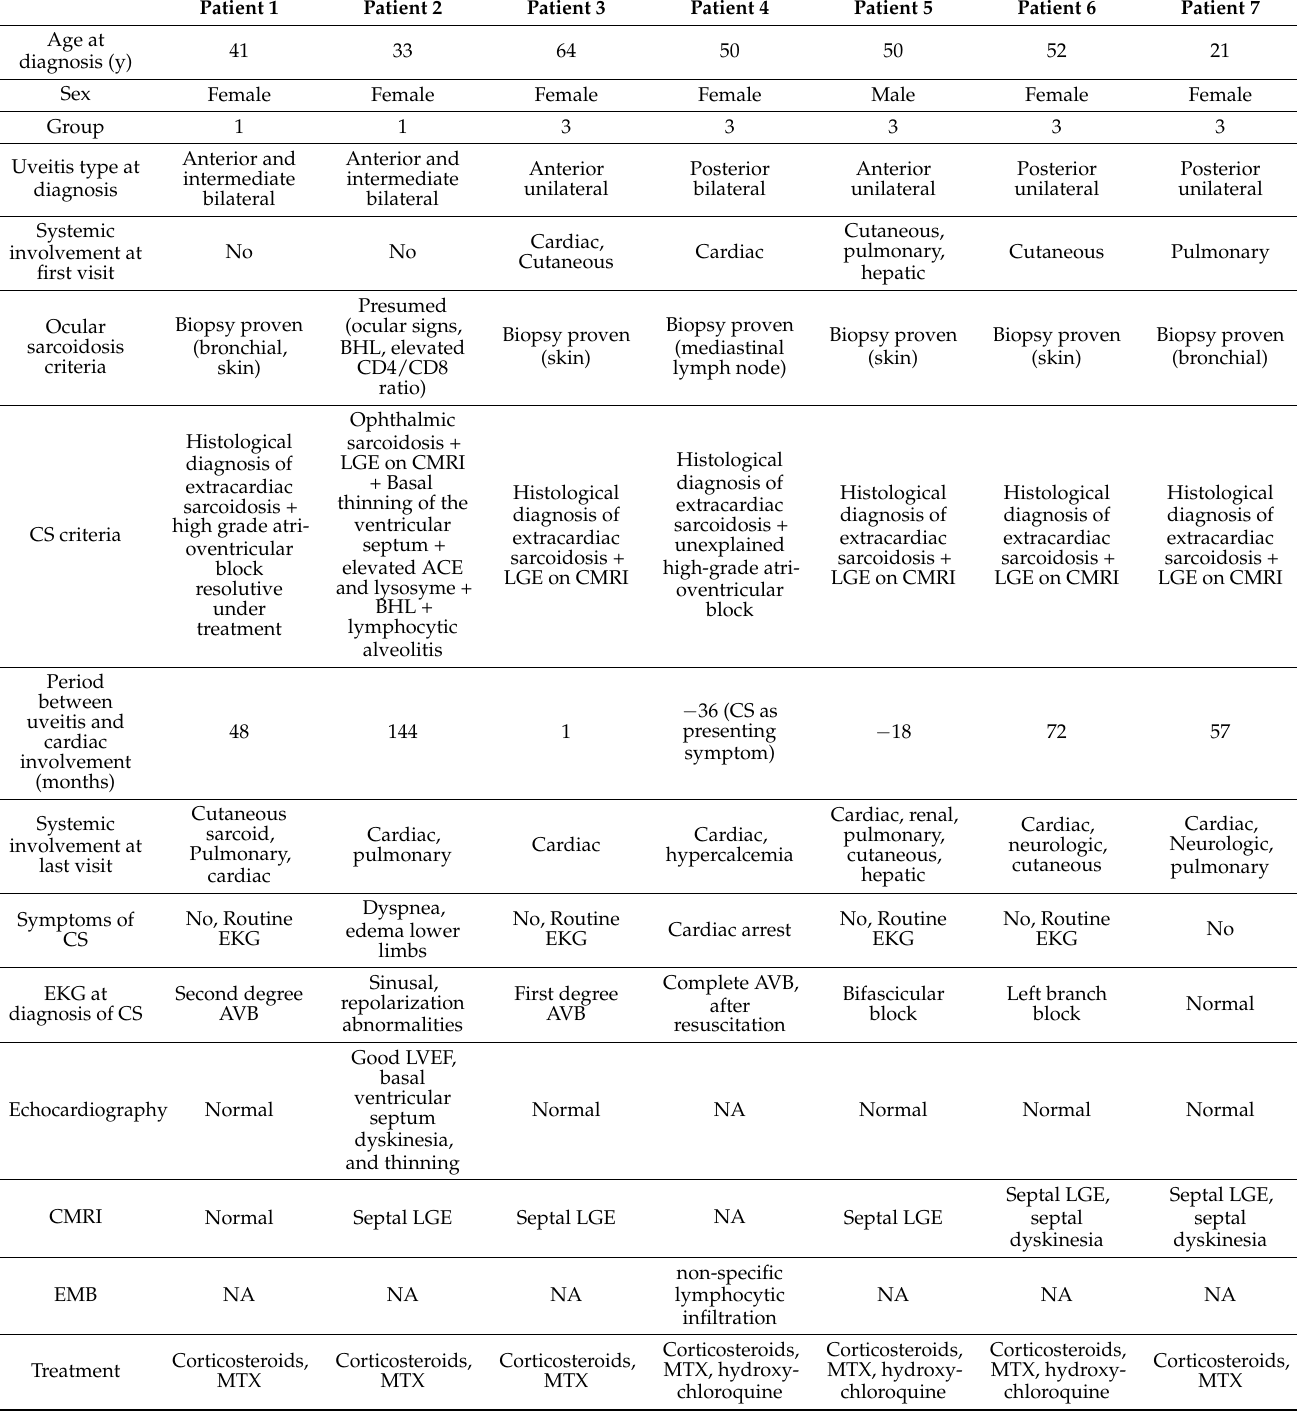
suffered from unilateral blindness. Table 3. Details of clinical history of patients with sarcoid uveitis with cardiac